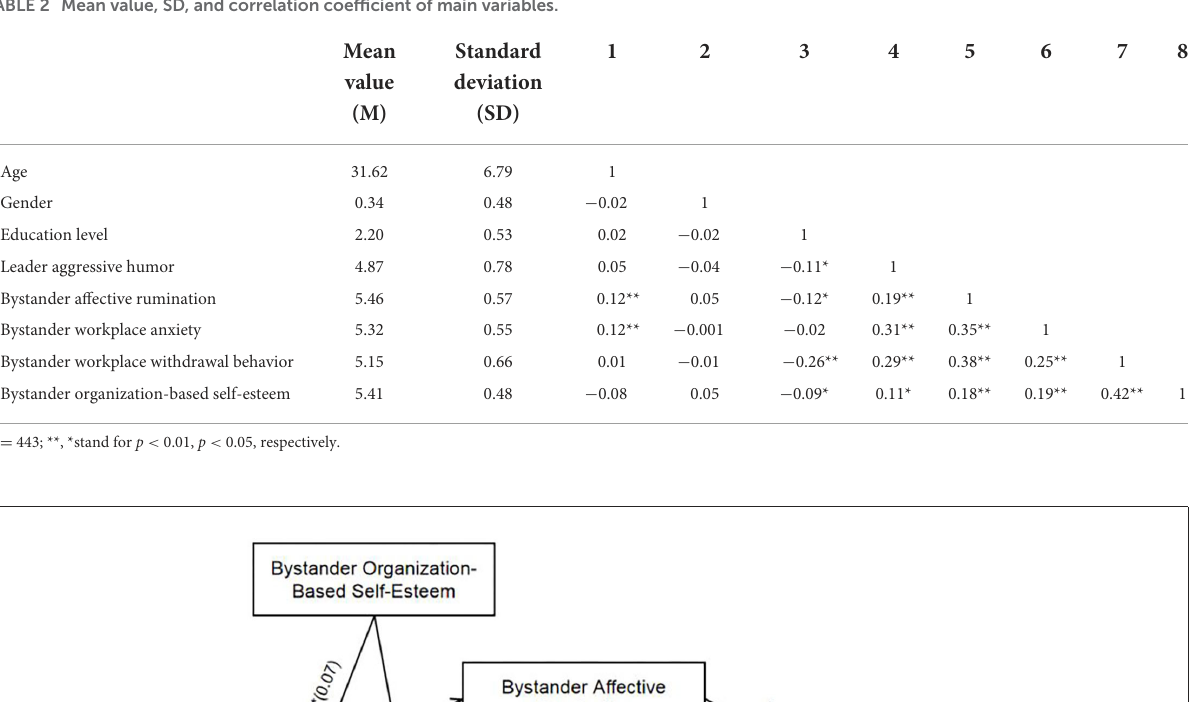
to the fitting indexes of the theoretical model ( x² = 322.79, df = 145, x² / df = 2.23, CFI = 0.93, TLI = 0.91, RMSEA = 0.05, SRMR = 0.07), it can be judged that the fitting of the model is good. Second, the results of path analysis are shown in Figure 2.